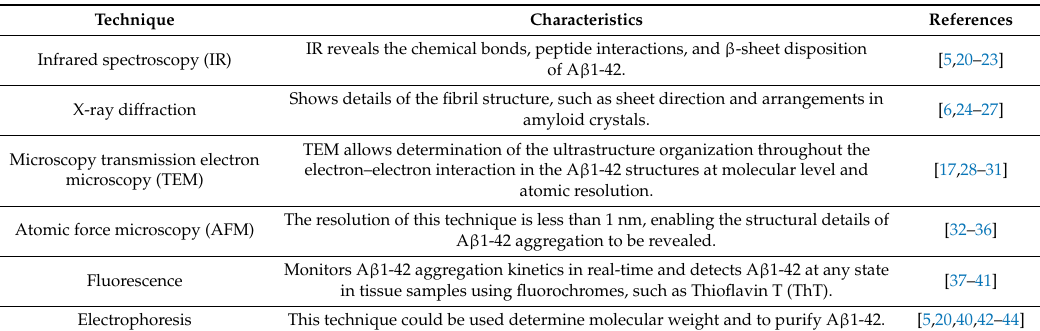
Table 1. Spectroscopic and biochemical techniques used in the characterization of the A β 1-42 structure and its fibrillation